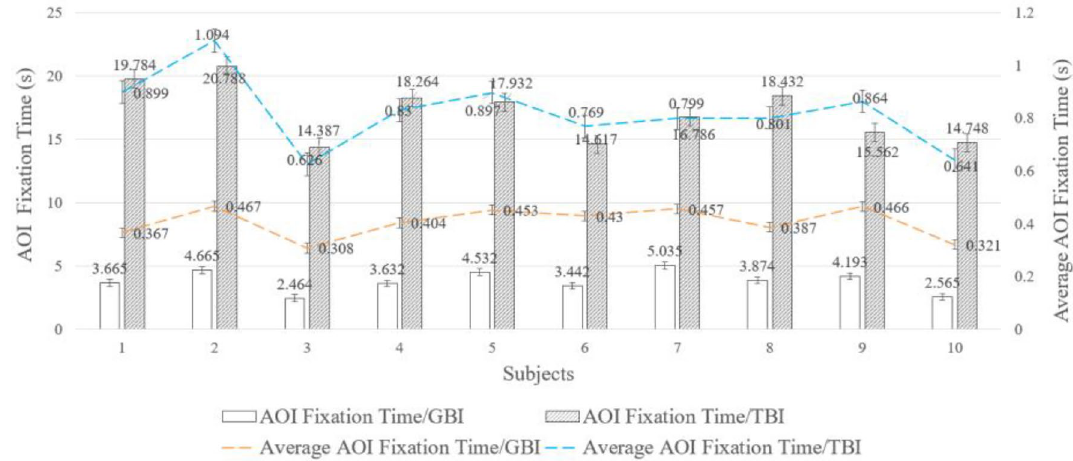
Fig. 10 The fixation time of